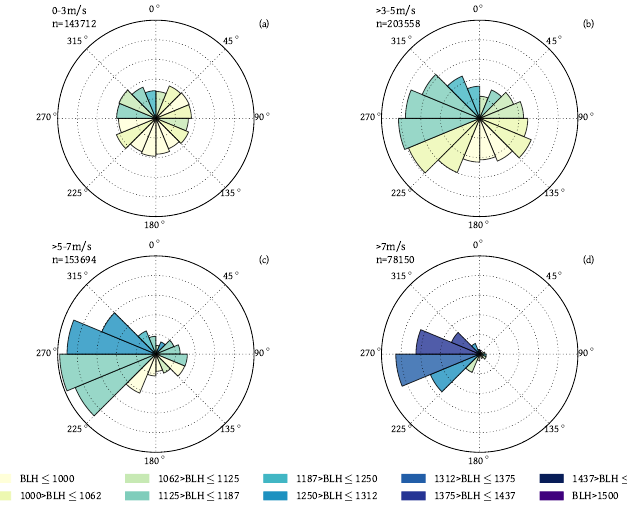
Figure 10. Relationship between BLH [m], wind direction and speed. Setup of figures ( a – d ) is identical to previous